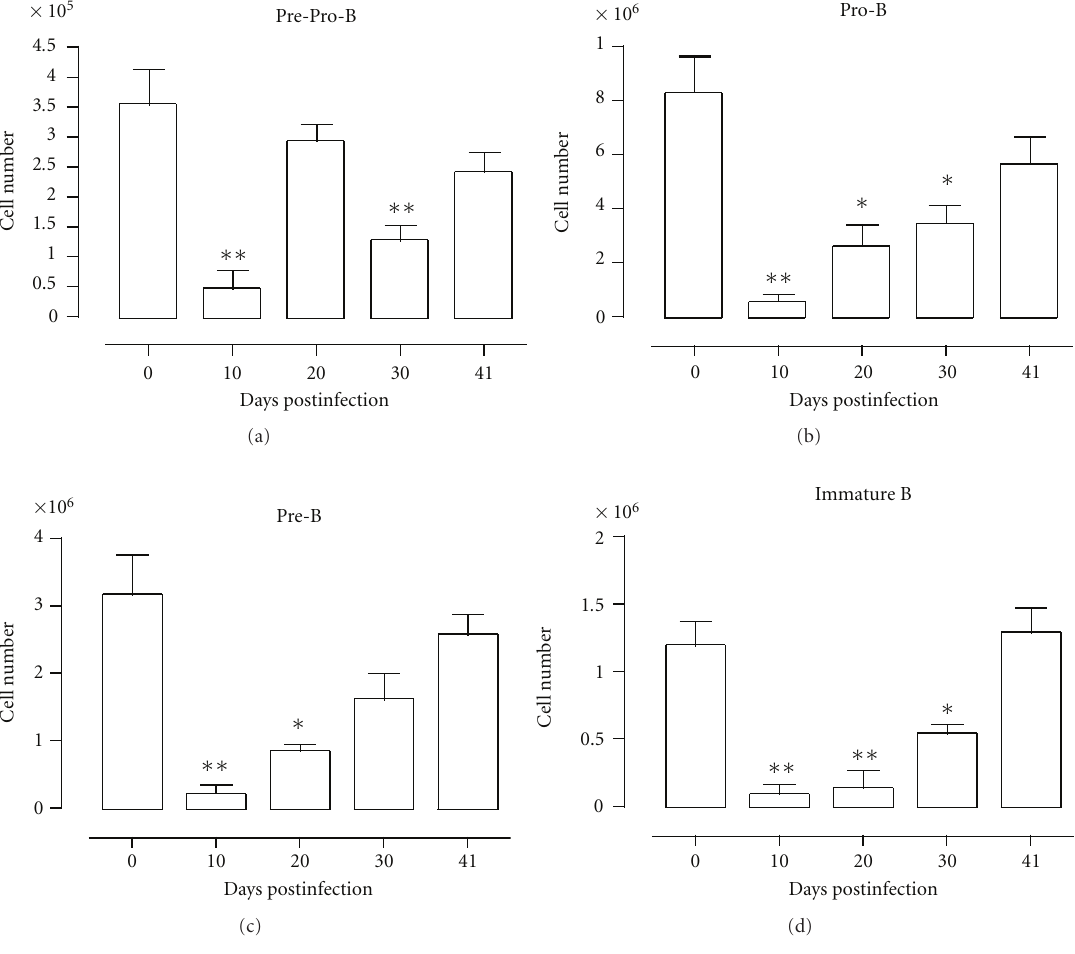
Figure 2: B dyslymphopoiesis in bone marrow during Pc AS infection. Bone marrow cells from uninfected mice and mice infected with Pc AS for 10–41 days were stained for surface markers commonly used to define developing B cells and analyzed using FACS. Data are represented as mean of three mice per group ± SEM, two independent repeat experiments were performed and statistics are compared to uninfected controls ( ∗ ) P < . 05, ( ∗∗ ) P < .